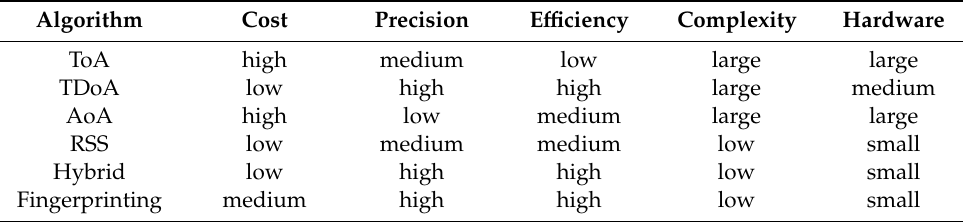
Table 1. Summary of localization